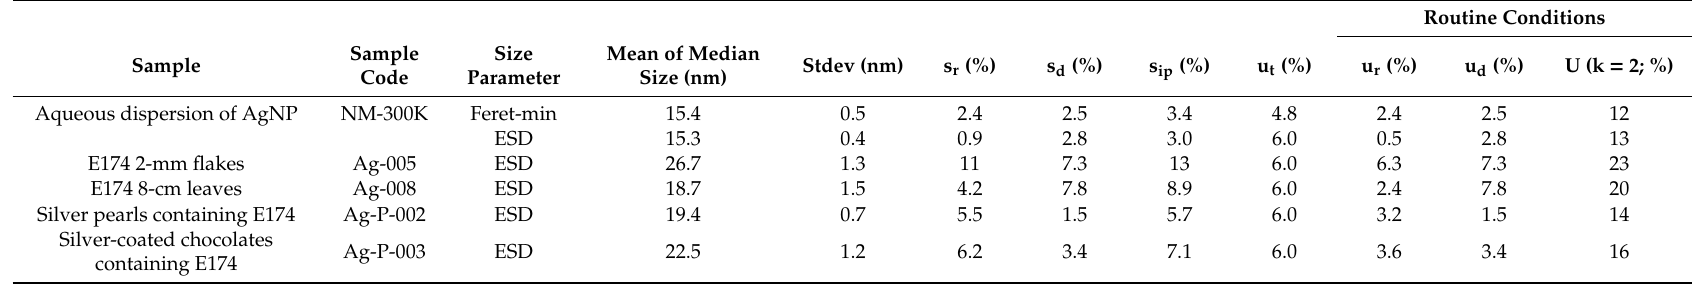
Table 1. Mean of the median nanoparticle sizes and their associated standard deviation, repeatability (s r ), between-day variation (s d ), and intermediate precision (s ip ). Contributions of the trueness uncertainty (u t ), within-day (u r ), and between-day (u d ) uncertainty to the expanded uncertainty (U) on the measurement of the median size by TEM (Feret-min) and spICP-MS (ESD) under routine measurement conditions (1 replicate × 1 day for Feret-min and 3 replicates × 1 day for